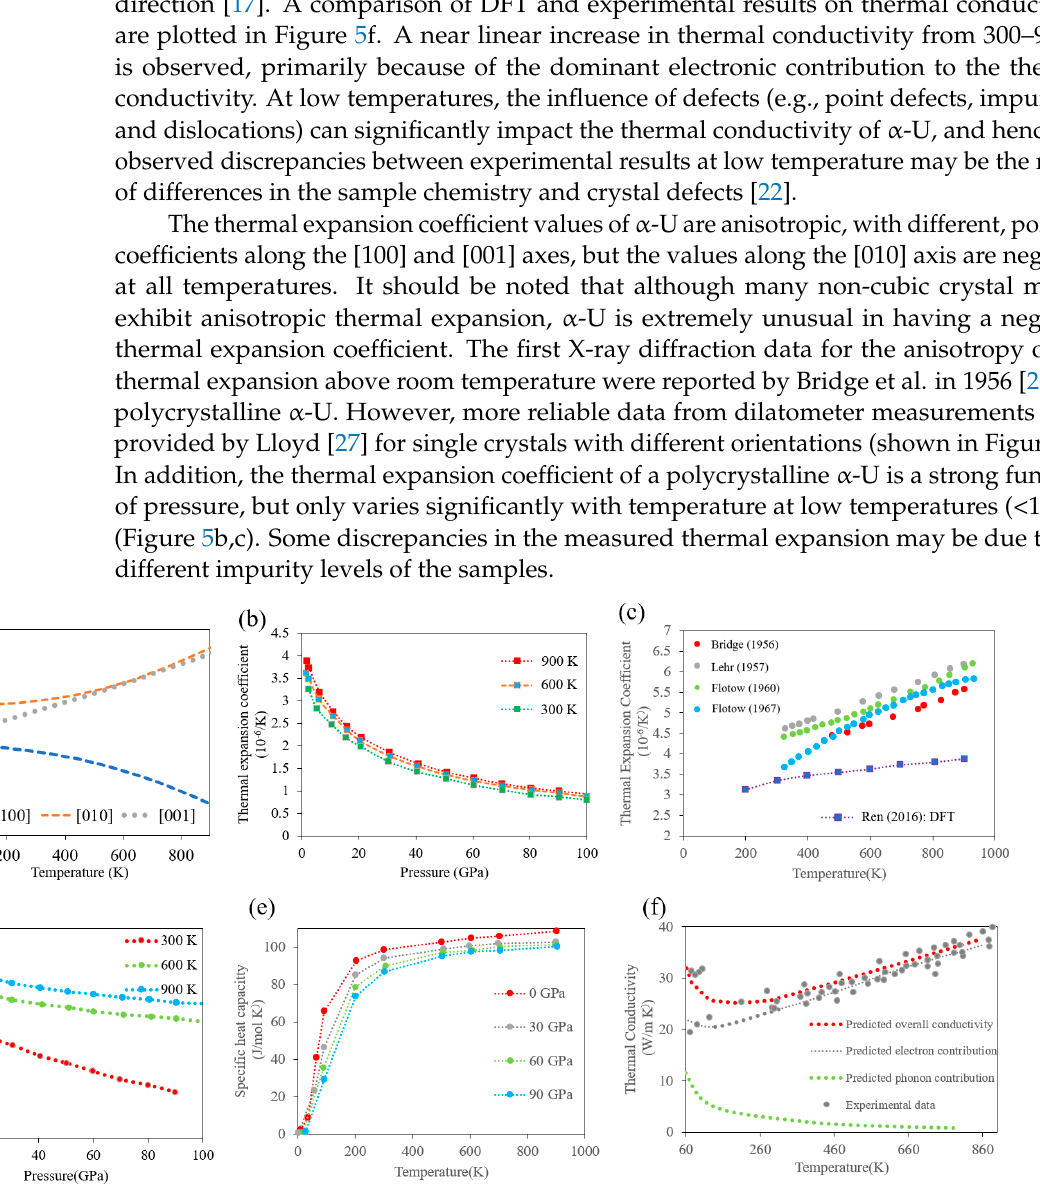
Figure 5. Thermal properties of α -U: ( a ) anisotropic thermal expansion coefficient in single crystals with different orientation (Reprinted/adapted from Ref. [19], 2022, Elsevier), ( b ) thermal expansion